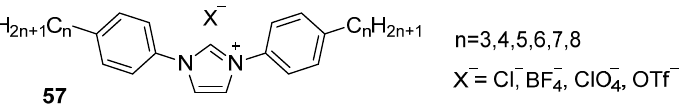
Figure 13. Generic structure of symmetric ArImAr-based ILCs with short aliphatic tails.